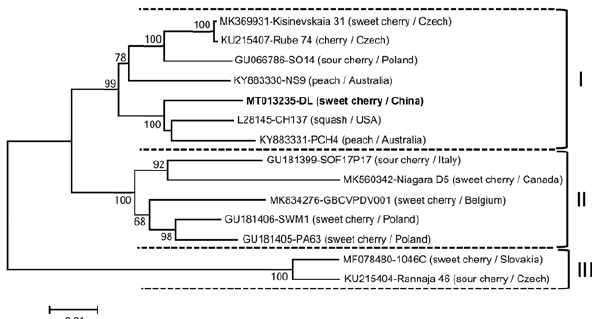
Figure 2. Phylogenetic analysis based on the near full-length sequence of RNA3, covering the complete coding regions of move- ment protein (MP) and coat protein (CP) genes and the intergenic region (IGR), of the prune dwarf virus (PDV) isolate examined in this study (PDV-DL), and 13 other PDV isolates available in Gen- Bank, without recombination events detected. The accession num- ber, isolate names, hosts and countries for each isolate are indicat- ed, and PDV-DL examined in this study is marked in bold. Phylo- genetic tree was constructed by the neighbor-joining (NJ) method with 1,000 bootstrap replicates, and genetic distance was calculated by the Tamura three-parameter model using MEGA